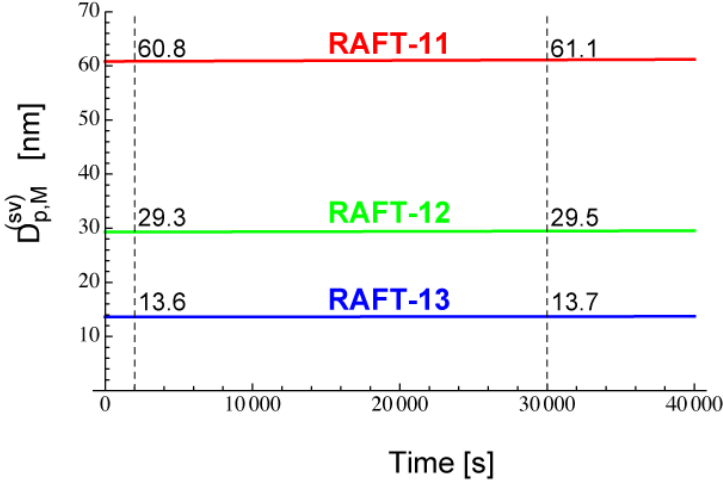
Figure 17. Calculated (cid:1830) (cid:2926),M(cid:4666)(cid:2929)(cid:2932)(cid:4667) developments for RAFT-11, -12, and -13, using Equation (25) with a = 10. The (cid:1830) (cid:2926),M(cid:4666)(cid:2929)(cid:2932)(cid:4667) -values at t = 2 × 10 3 and 3 × 10 4 s are shown in the figure.